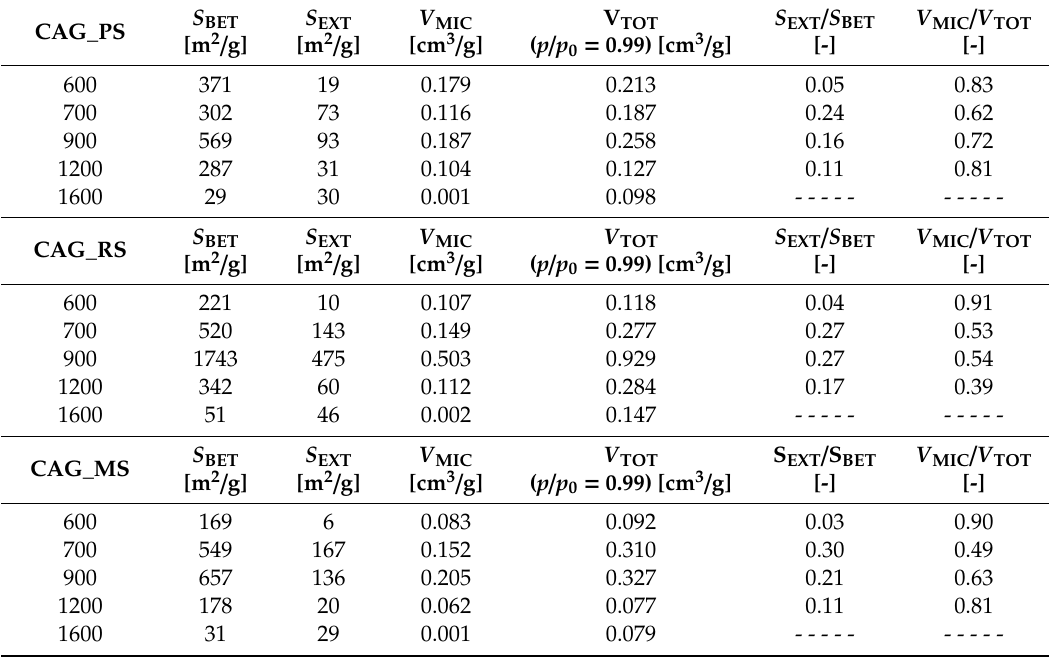
Table 1. Textural parameters of the samples obtained by nitrogen sorption